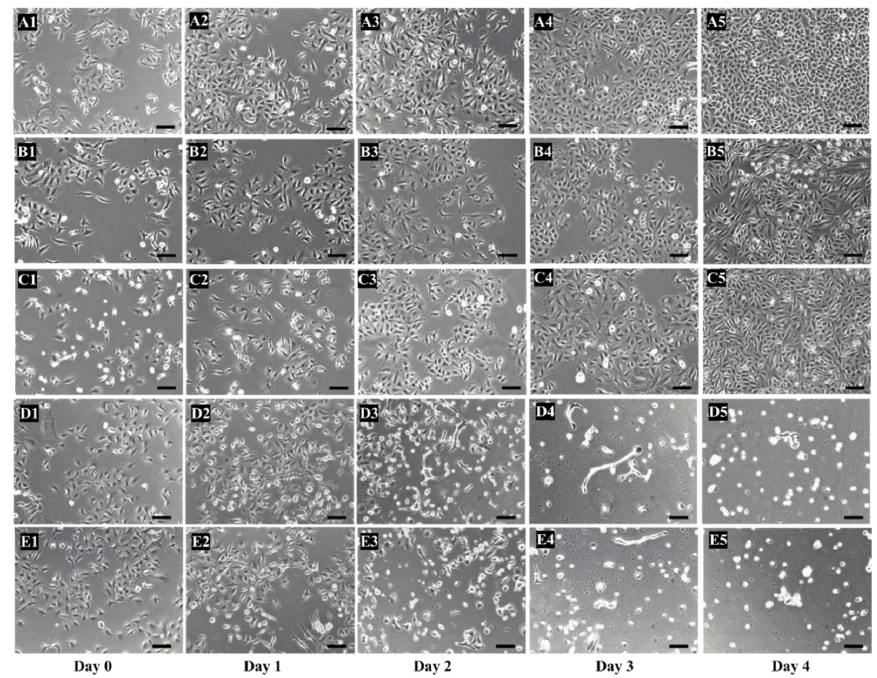
Figure 6. Photomicrographic images of A549 cell over the course of 4-day cultivation. ( A1 – A5 ) negative control group 1: untreated A549 cells; ( B1 – B5 ) negative control group 2: A549 cells treated with 5 (cid:48) -DFUR; ( C1 – C5 ) negative control group 3: A549 cells tethered with coreSA protein and treated with 5 (cid:48) -DFUR; ( D1 – D5 ) A549 cells decorated with TP-coreSA fusion protein and treated with 100 µ M of 5 (cid:48) -DFUR; ( E1 – E5 ) positive control group—A549 cells treated with 100 µ M of 5-FU (scale bar donates 100 µ